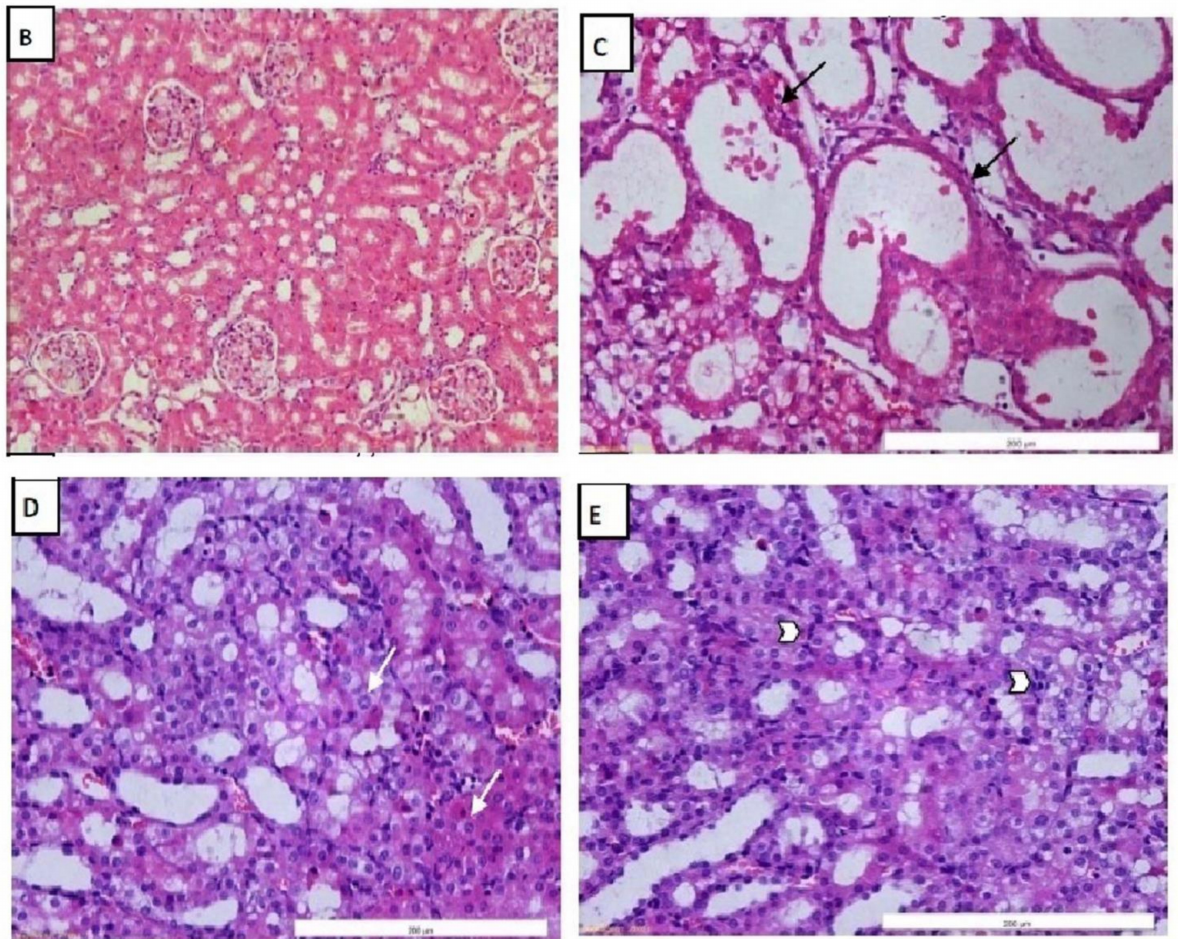
Figure 5. H&E staining showing the structure of renal tissue and damage score at different time inter- vals, showing ( A ) effects of MSCs pretreated with rapamycin on tubulointerstitial damage score at different time intervals, ( B ) kidney specimens with normal kidney structure (control group at 7 days), ( C ) apoptotic cells with dilated irregular tubules (black arrow) (Cisplatin 7 days), ( D ) prominent nucleoli with few apoptotic cells (white arrow) (ADMSC group at 7 days), ( E ) regeneration in the form of mitotic figures (arrow head) (Rapa + ADMSC group at 7 days). * Significant vs. control, # significant vs. Cis group and $ significant vs. ADMSC